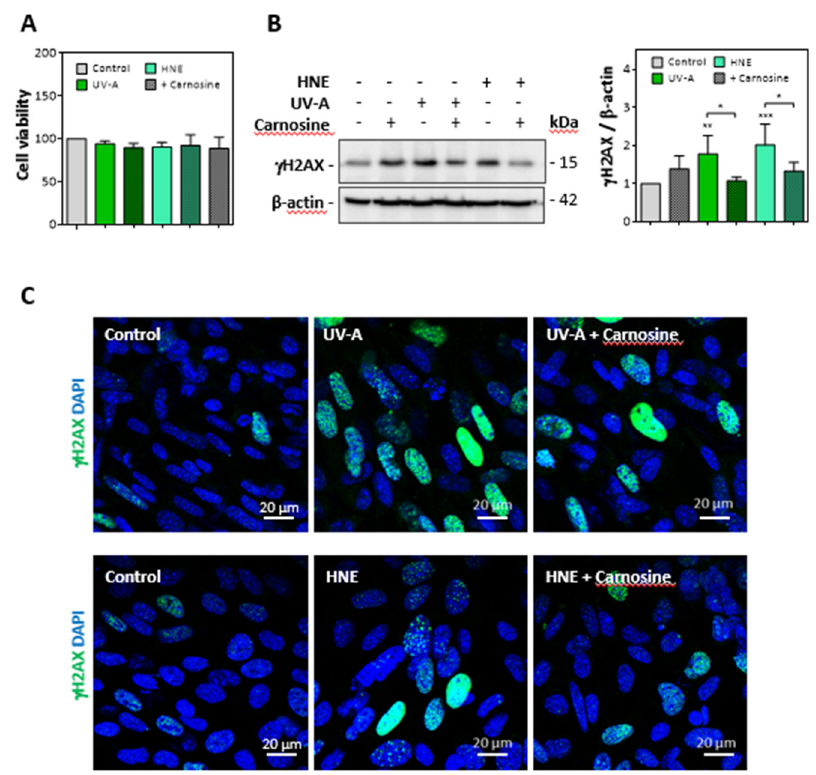
Figure 3. Expression of γ -H2AX evoked by UV-A or HNE in fibroblasts nuclei. Fibroblasts were exposed to UV-A (two cycles of irradiation, each up to 15 J/cm 2 in HBSS medium) or HNE (30 µM, 4 h in HBSS medium), ± carnosine (100 µ M). ( A ), Cell viability evaluated by the MTT test, in fibroblasts exposed to UV-A or HNE, ± carnosine. ( B ), expression of γ H2AX and protective effect of carnosine evaluated by western blot of fibroblasts exposed to UV-A or HNE, as described in 3A. Right panel, statistical quantification of γ H2AX, expression, data are represented by means ± SEM of four independent experiments. * p < 0.05; ** p < 0.01; *** p < 0.001. ( C ), immunofluorescence and confocal imaging of γ H2AX foci in fibroblasts treated by UV-A (upper panels) or HNE (lower panels) ± carnosine. Nuclei were stained with DAPI. Scale bar, 20 µm.